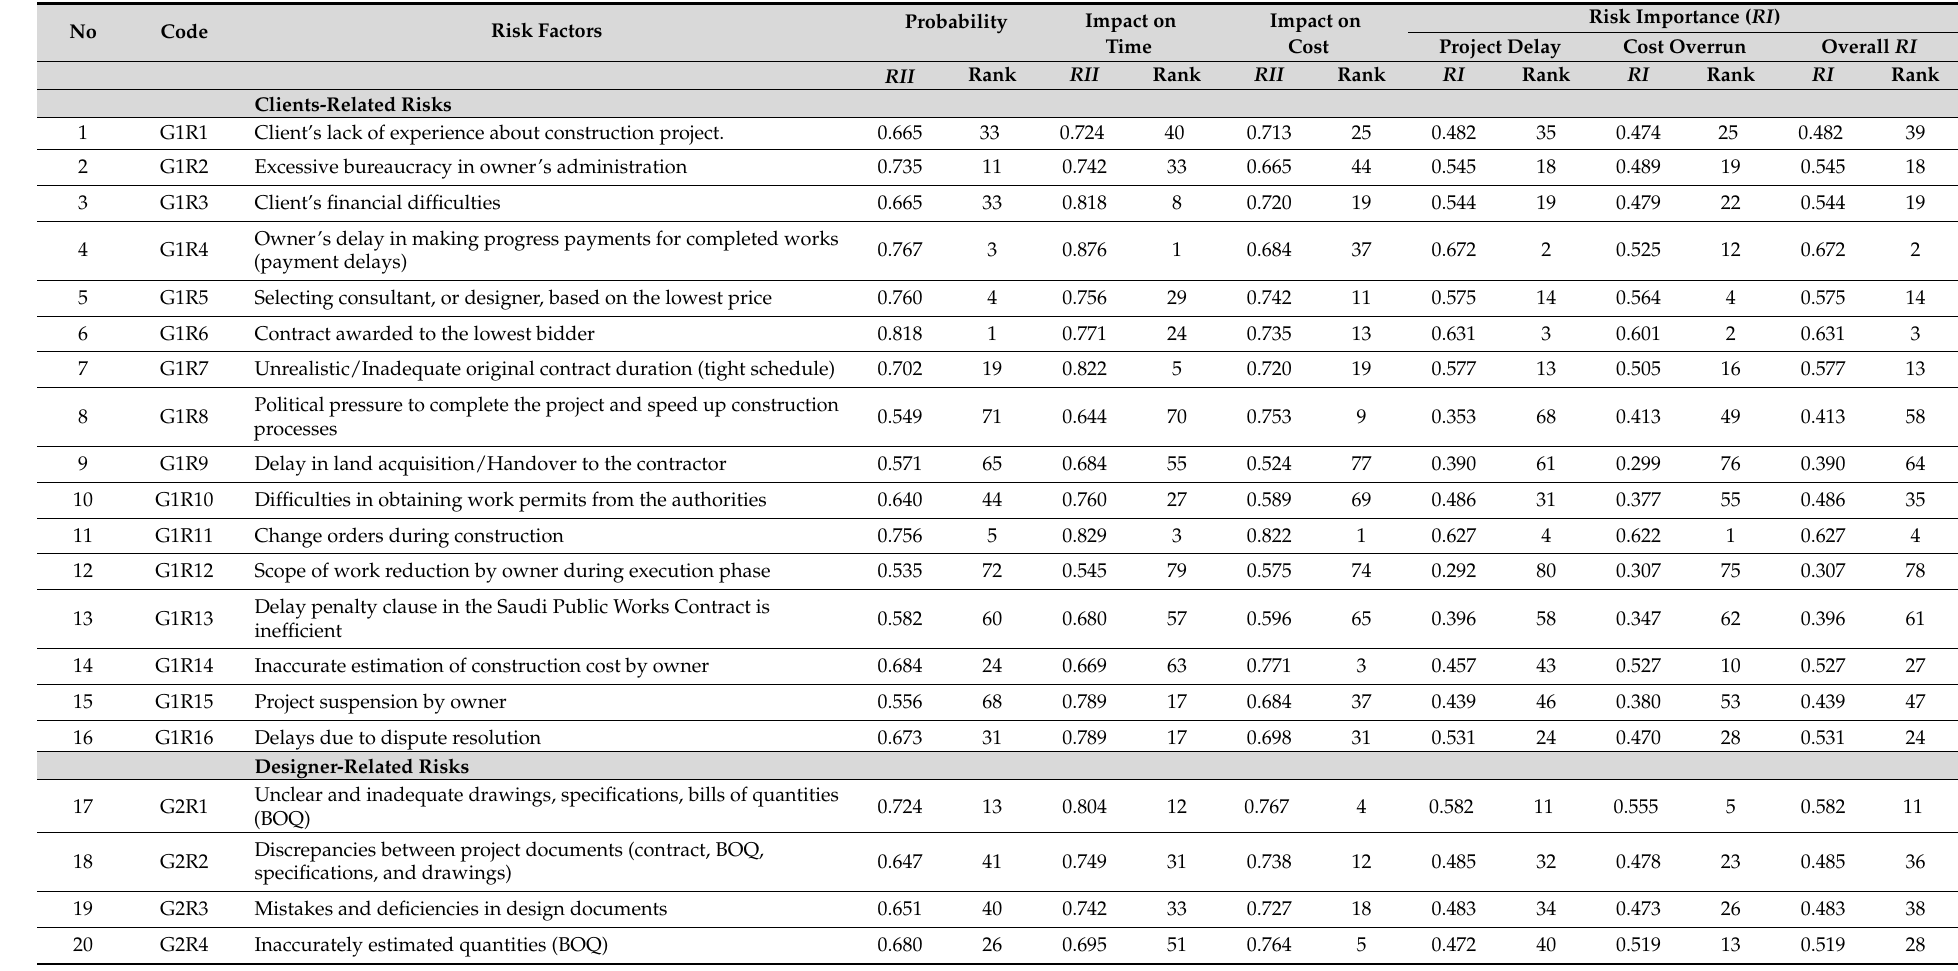
Table A2. RII for risk factors of building construction projects and